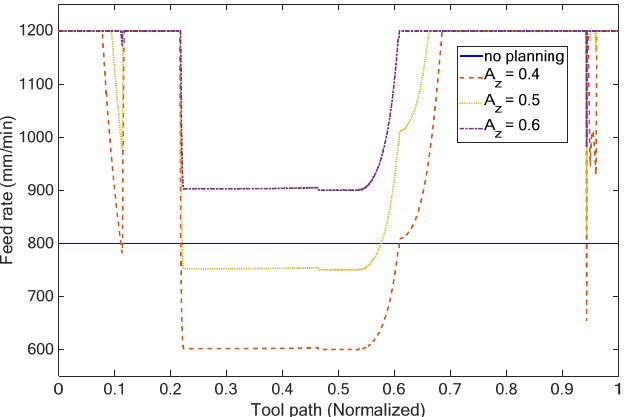
Figure 9. Variation in feed rate for different cutting areas per cutter tooth.